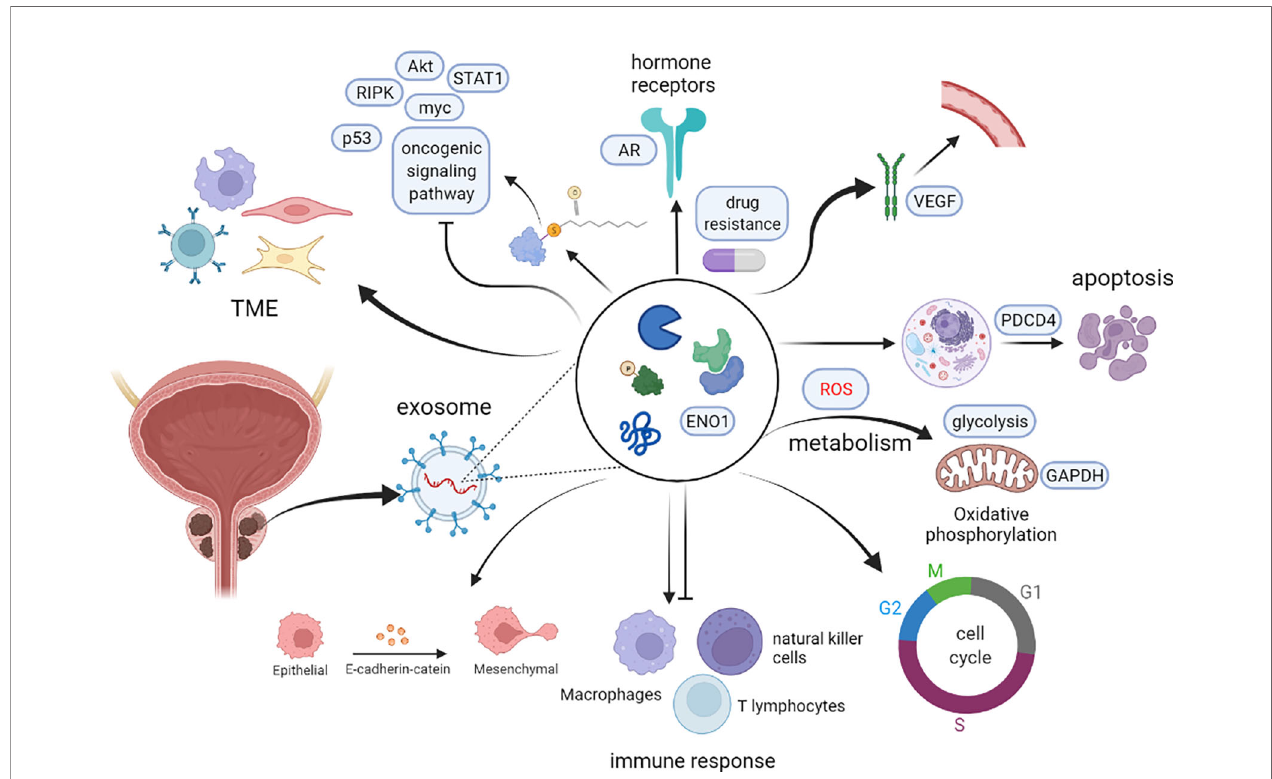
FIGURE 3 | The potential role of PCaDEPrs in cancer. Exosomes originating from the tumor cell play a crucial role in tumor development. During tumor initiation, they mediate apoptosis, lipid metabolism, TME, and tumorigenic signaling, and also interfere with the cell cycle to induce cancer development. During tumor survival and progression, they regulate remodeling the tumor microenvironment, hormonal regulation and metabolic alterations, as well as lysosomal function and distribution, and inhibition of cancer cell apoptosis. During tumor metastasis, PCaDEPrs can contribute to EMT transformation, trigger microenvironment alteration, and establishment of a pre-metastatic ecological niche. Finally, they can also regulate tumor resistance to chemotherapeutic